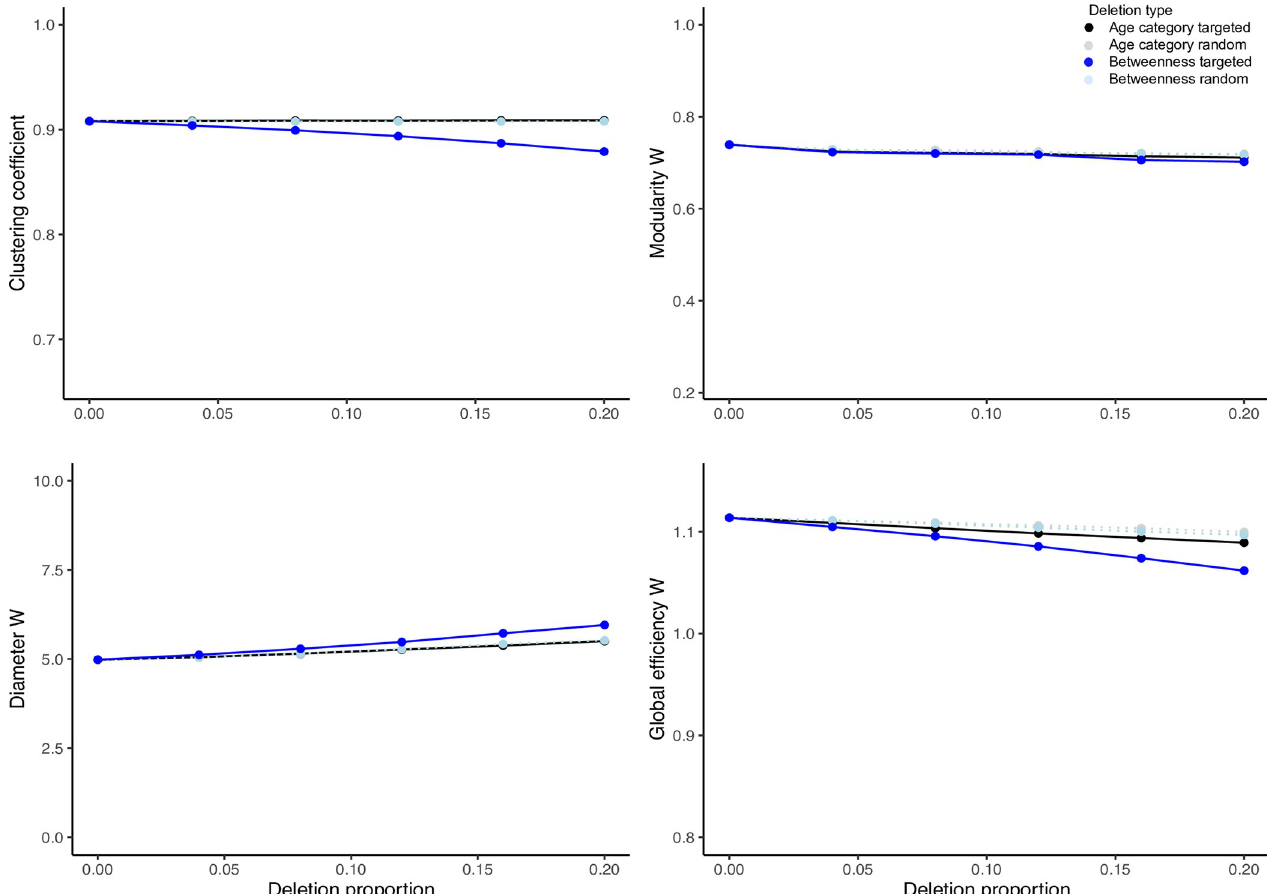
Fig 5. Graphs representing results (mean plus 95% confidence interval) of 100 deletions per each combination of deletion proportion (i.e., 0–20%) and type (i.e., random vs. targeted) in an example virtual network that is comparable in size to the empirically based social network (see Figs 3 and 4 for detail). The deletions were either targeted according to age category (black series) or betweenness centrality (blue series); or were random (grey and teal series represent random deletions without considering individual traits conducted as control conditions to age- or betweenness centrality-targeted experiments, respectively). The network indices evaluated included clustering coefficient as well as weighted modularity, diameter and global efficiency. For a cross-species context, the minima of y-axis ranges per clustering coefficient as well as weighted modularity and global efficiency are plotted to express the minima from a similar, theoretical treatment in an egalitarian primate society [46]. The weighted diameter index depends on group size, thus the pertinent y-axis is not expressed in a cross-species context. For results of Hedge’s g test expressing the difference in the effect size between the means of each network index between targeted versus random deletions along the deletion proportion axis and per deletion type, refer to S3 Table.